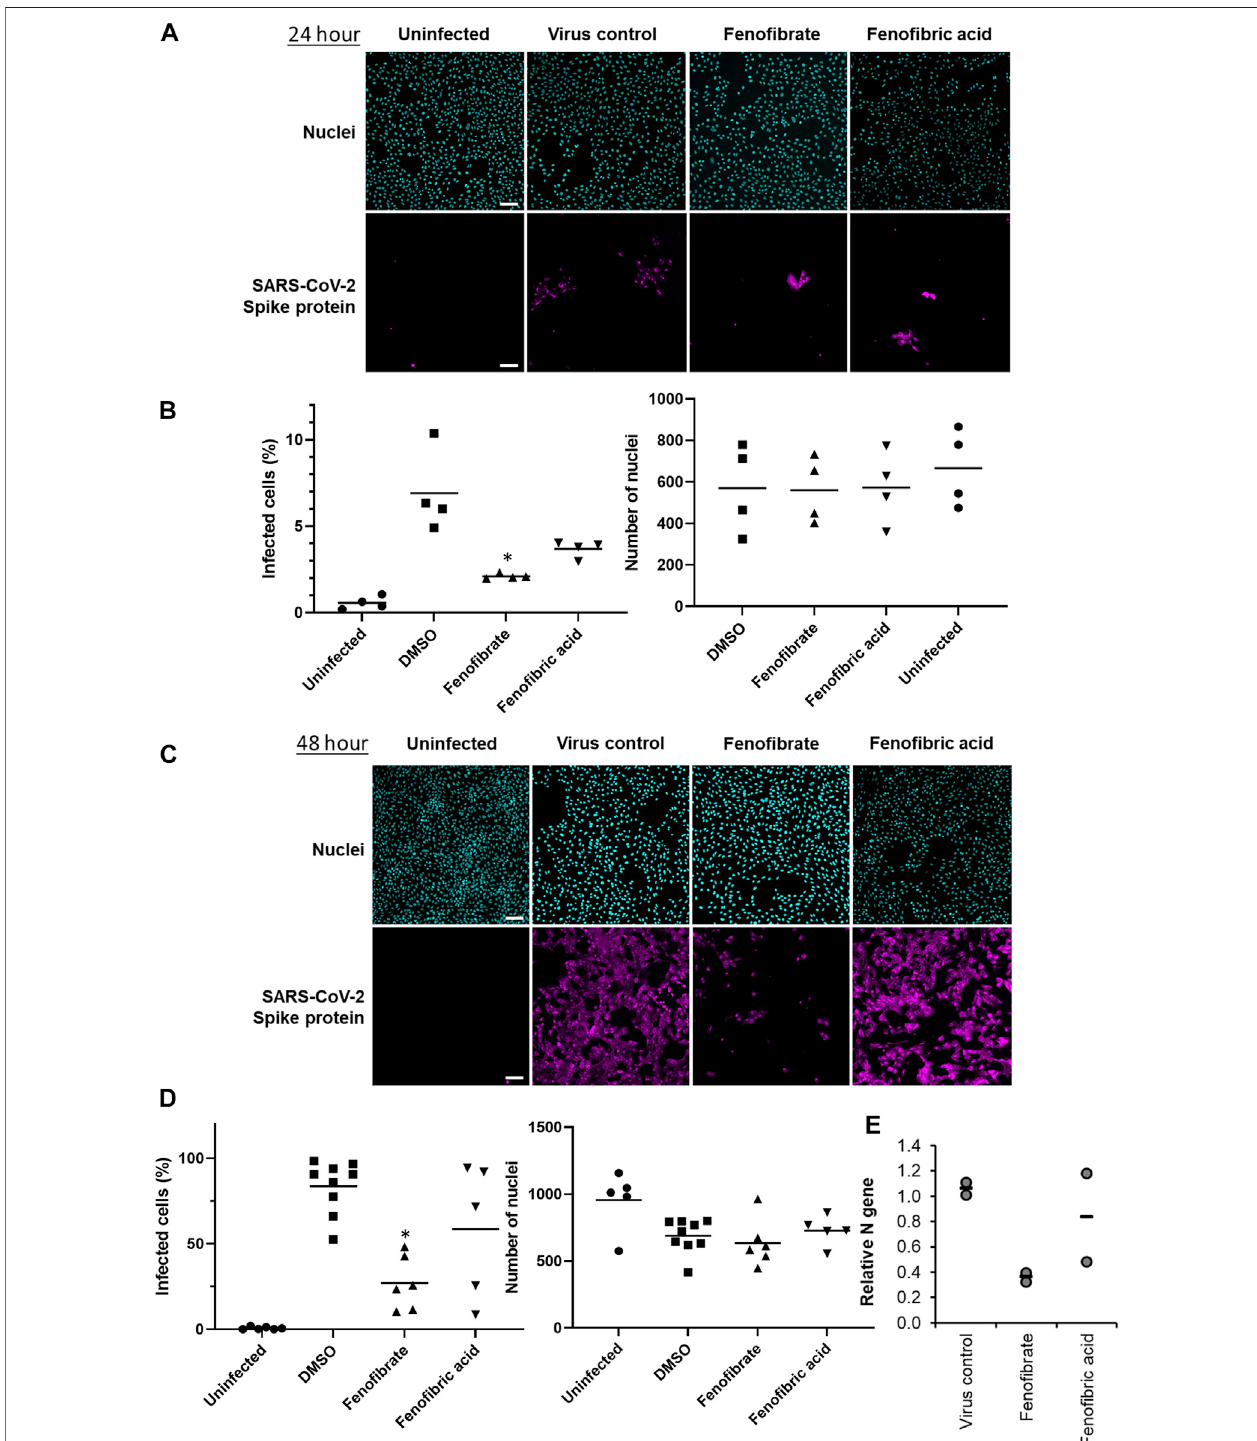
FIGURE 3| Feno fi brate and to alesser extent feno fi bric acid reduce SARS-CoV-2 infection at both 24 and 48 h. Verocells were plated into 96-well plates(8 × 10 3 cells/well) for 24 h before infecting with 167IU of hCOV-19/England/2/2020 virus isolate in the absence or presence of 230 μ M feno fi brate or feno fi bric acid. Infection rateswereassessedat24and48 hbystainingVerocellsforviralspikeproteinandcounterstainingnucleiwithHoechst.CellswereimagedandanalyzedusingaThermo Scienti fi cCellInsightCX5HCSplatform.RepresentativeimagesandmeandataareshownforVerocellsincubatedfor24 h( A and B )and48 h( C and D ).Theblack barsare%infectedcellsandthehatchedgraybarsaretheaveragenumberofnucleiscoresper fi eldofview(mean ± SD,n (cid:2) 2-3;one-wayANOVA,* p < 0.05compared to virus control). E. Supernatant was collected from wells after 48 h of incubation. Virus was heat-inactivated and viral N gene RNA levels were measured directly in the supernatant using a commercial one-step RT-qPCR reaction. N RNA levels were calculated relative to supernatant from virus control (n (cid:2) 4 experiments).